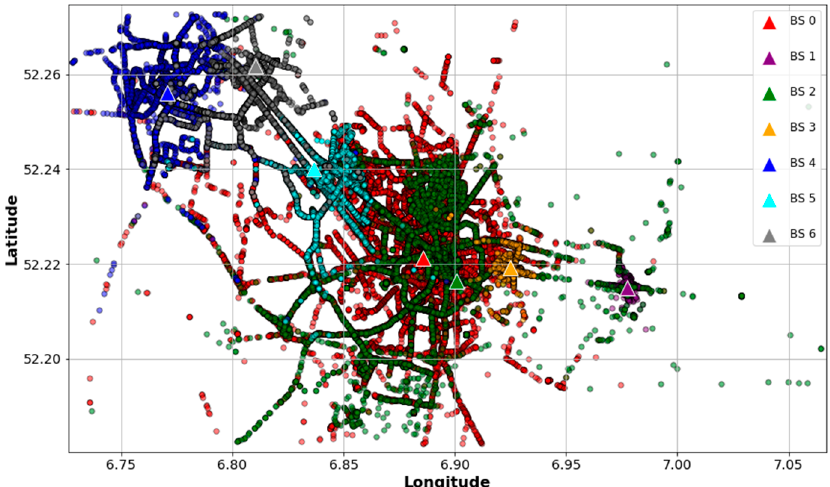
Figure 2. Locations of BS and their associated devices within the selected urban area.